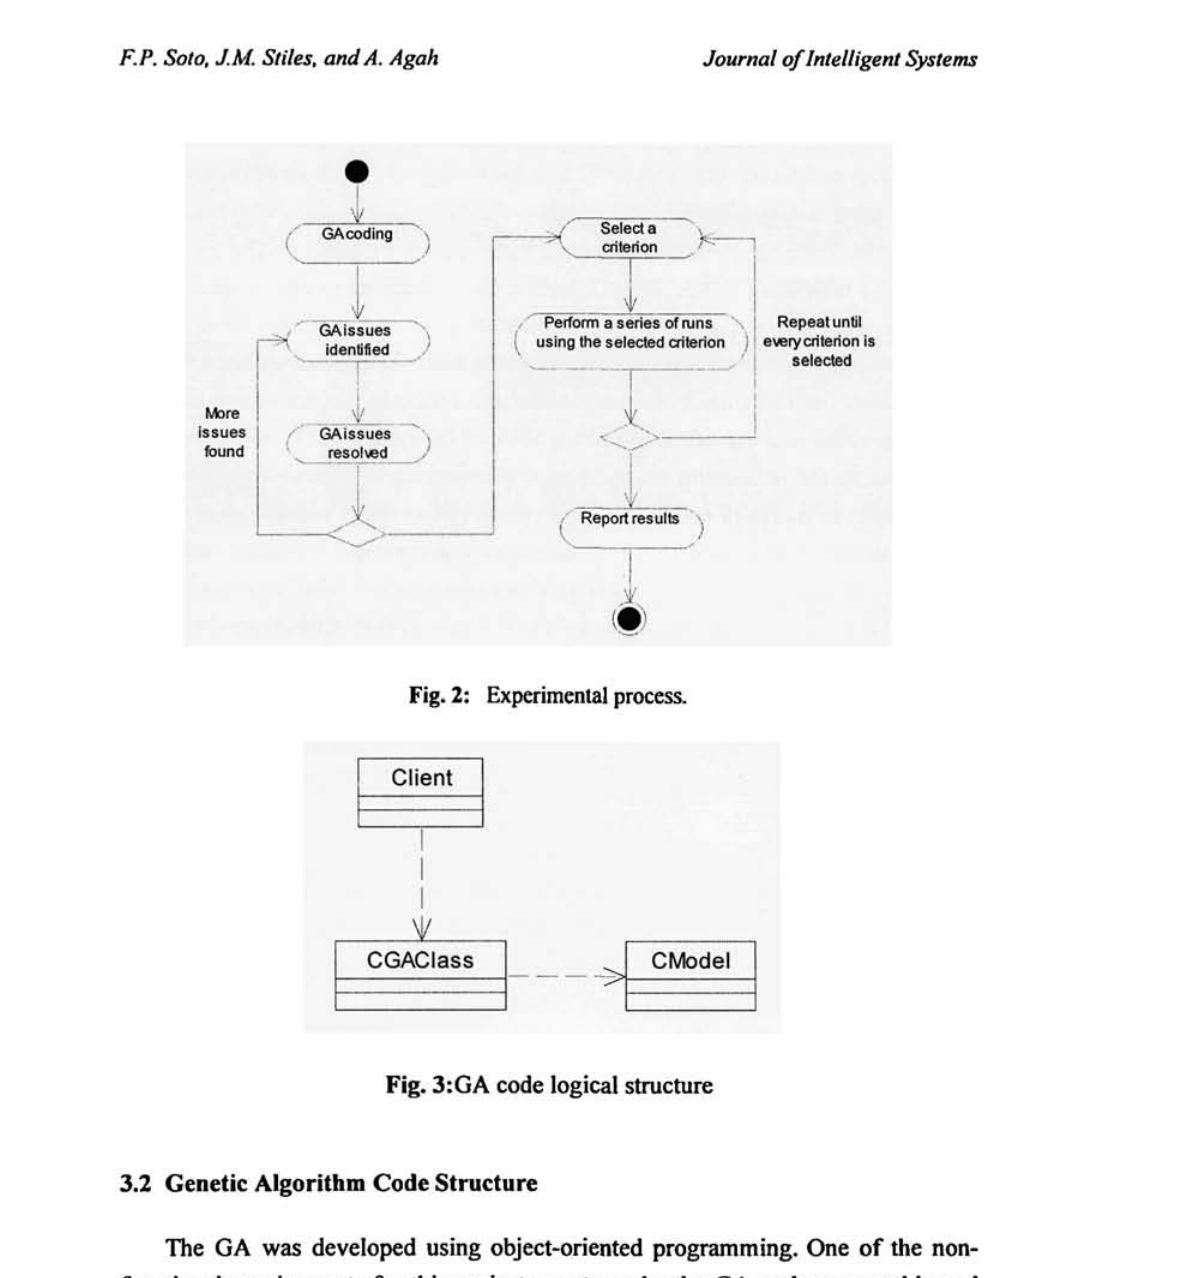
Fig. 2: Experimental